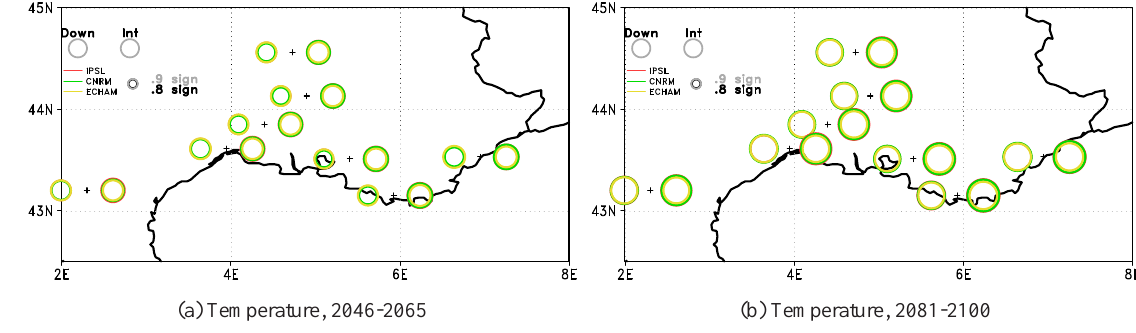
Fig. 6: Circle areas are proportional to the KS scores computed over the whole year (i.e., no seasonal discrimination) between the CDFs of temperature from each GCM during the validation period and those during the two future periods (2046-2065 on the left and 2081-2100 on the right) under the A2 scenario. Crosses indicate the location of each station. The CDFs are computed using either the interpolation (right side with respect to the cross) or the downscaling method (left side with respect to the cross). Black and grey circles display the 80% and 90% confidence levels (i.e., α = 0 . 2 and 0 . 1 ) of the KS scores. Table 4. Values (averaged over the 7 stations) of the 5%, 50% and 95% quantiles for temperature (in degrees Celsius) and 50% and 95% for wind speed (in ms − 1 ) and precipitation (in mm) for the calibration period, and for the two future time slices (2045–2065 and 2081–2100) using the interpolation (Int) and CDF-t (Down) methods with the various CMIP3 models (IPSL, CNRM and ECHAM5) for scenarios